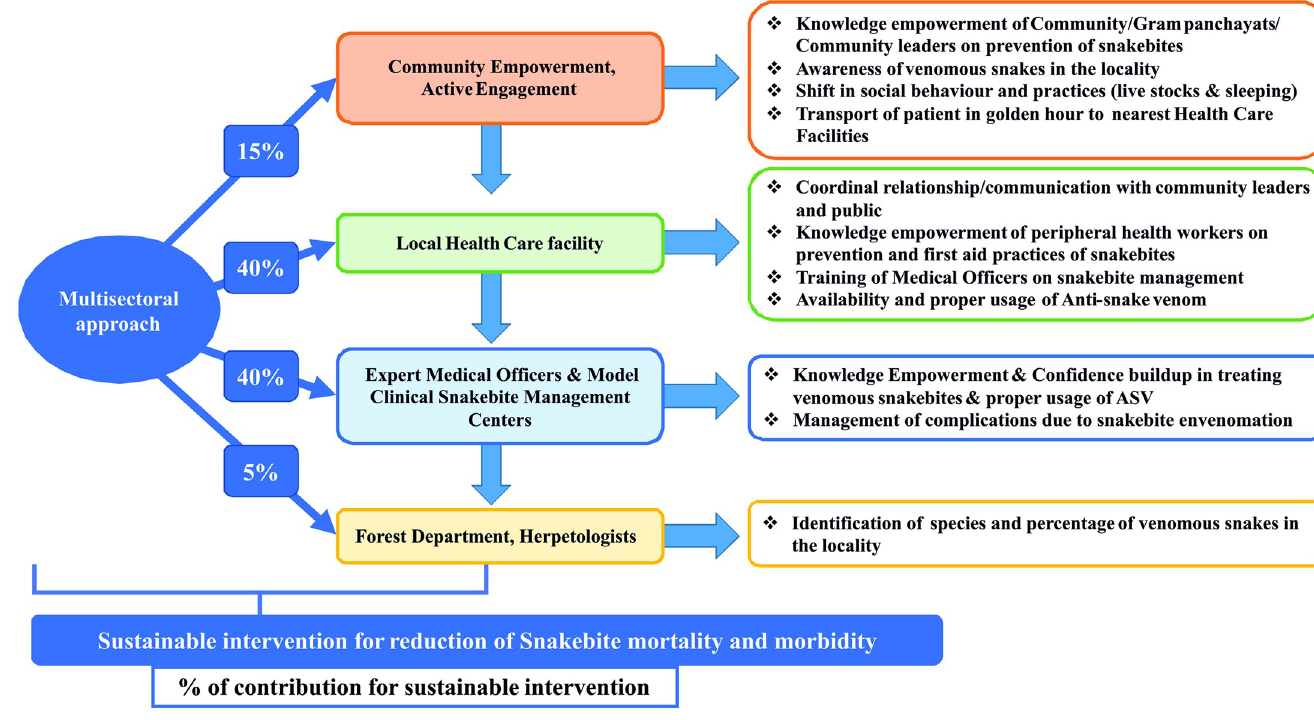
Fig 5. Multi-sectoral model for reduction of snakebite mortality and morbidity in rural India.